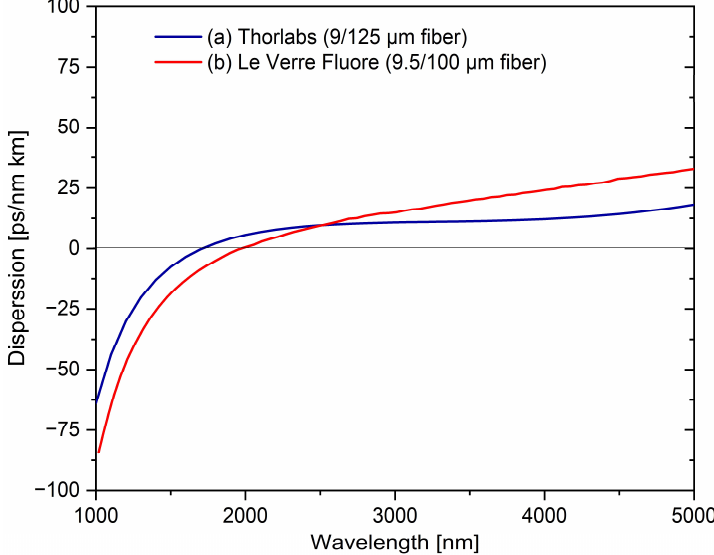
Figure 3. Dispersion profile of single-mode fluoroindate fibers manufactured by Thorlabs ( a ) [94] and Le Verre Fluore ( b ). ( b ) Reproduced with permission from [59]. Copyright 2018, Chinese Laser Press.